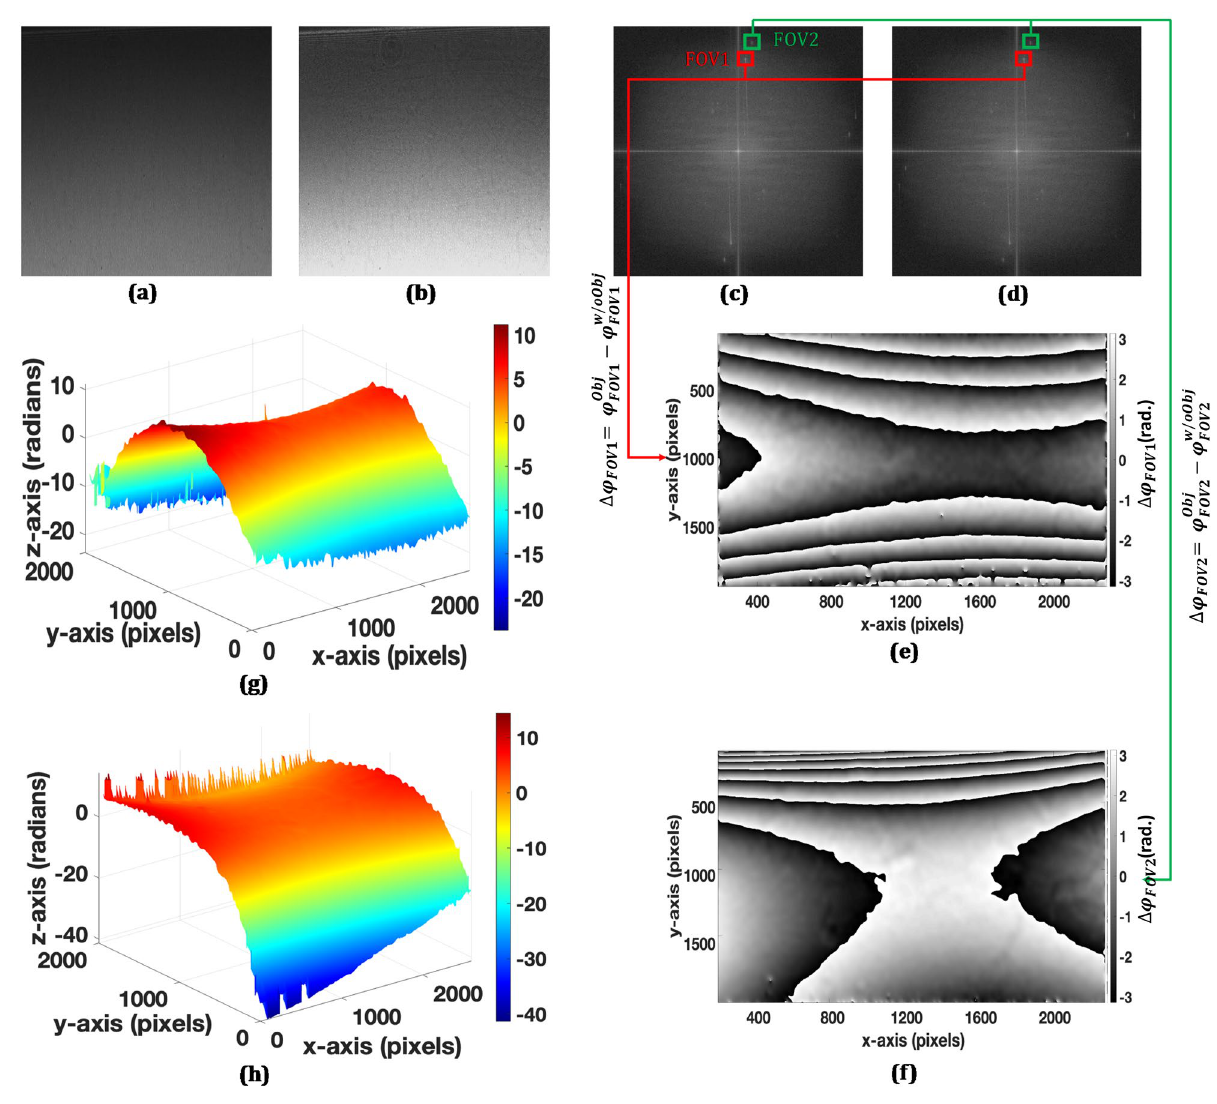
Figure 7. ( a ) Recorded digital hologram with the candle flame, ( b ) recorded digital hologram without the glass plate, ( c – d ) Fourier transform spectrums of ( a ) and ( b ), ( e – f ) wrapped phase difference maps corresponding to FOV1 and FOV2, respectively, and ( g – h ) unwrapped phase distributions corresponding to ( e – f ),